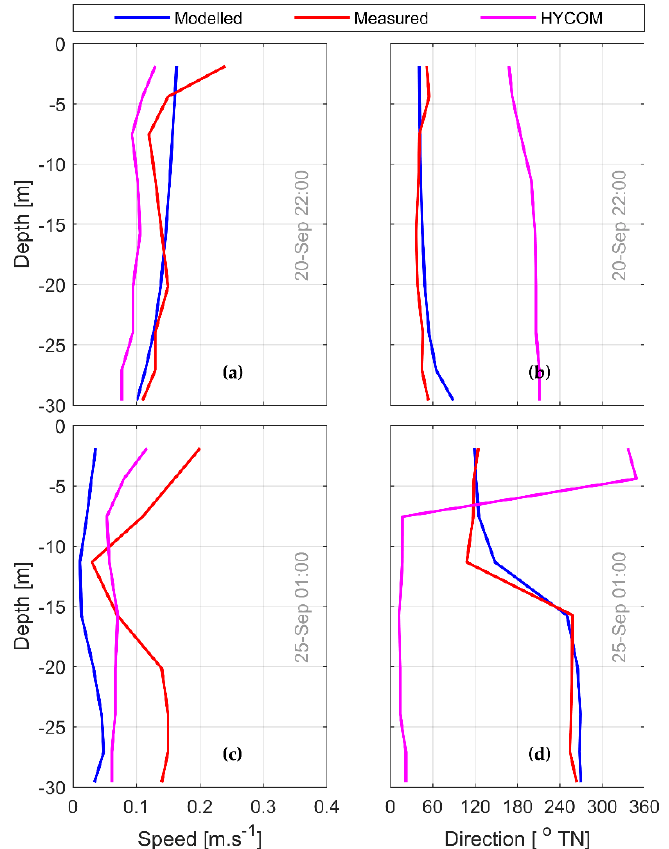
Figure 3. Two snapshots ( a , b ) and ( c , d ) of vertical current profiles for the Table Bay calibration site (CU1) from late September 2006. These profiles demonstrate the reasonable reproduction of the vertical flow structure. In the second snapshot ( c , d ), a reversal in direction is evident roughly between 11 and 15 m and is well-simulated by the